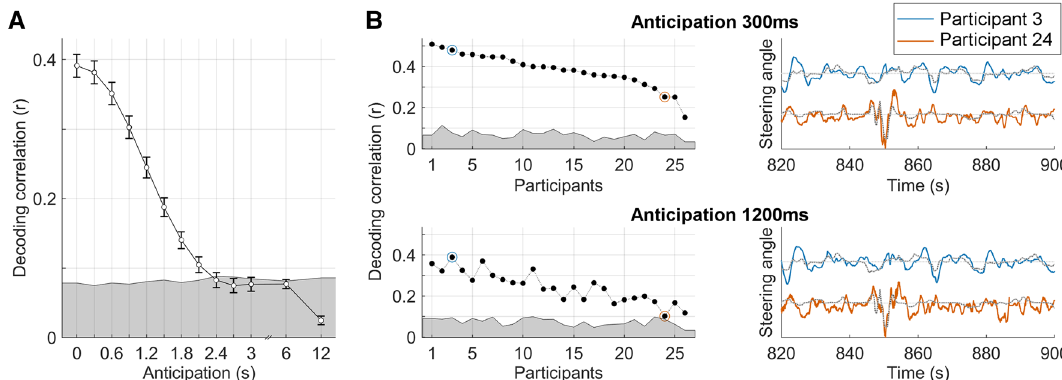
Figure 3. EEG decoding of continuous steering actions. ( A ) Backward TRF models were used to decode the steering signal from unseen EEG data with cross-validation. Steering reconstruction correlations are reported for TRF models with various anticipations (with a fixed TRF window-size of 1.5 s). Error-bars indicate the SE across participants. The grey area indicates the chance level, which was the 99th percentile of a null distribution calculated by re-running the regression analysis 100 times on shuffled steering/EEG data (calculated across all participants and shuffles). ( B ) (Left) Individual-subject steering reconstruction correlations for selected anticipation windows. Participants were sorted according to the results with anticipation 300 ms. (Right) Selected portion of the steering signal (grey lines) and the corresponding steering reconstructions for two selected participants. Decoding results for those participants are also indicated in panel B with the same